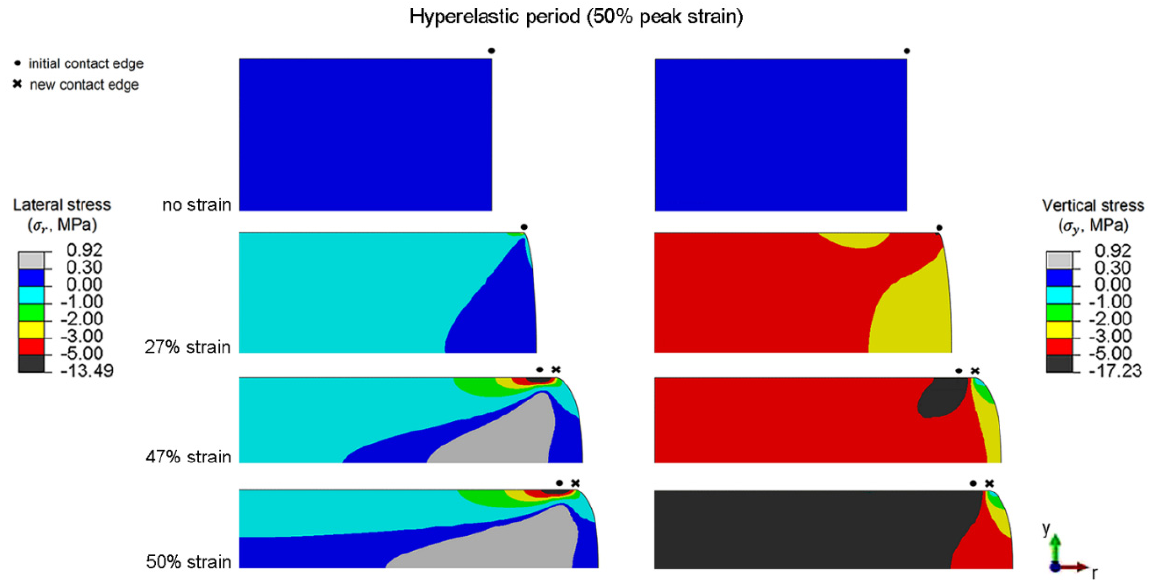
Figure 13. Distributions of the lateral and vertical stresses of disc-A during the hyperelastic period (50% peak strain). (50% peak